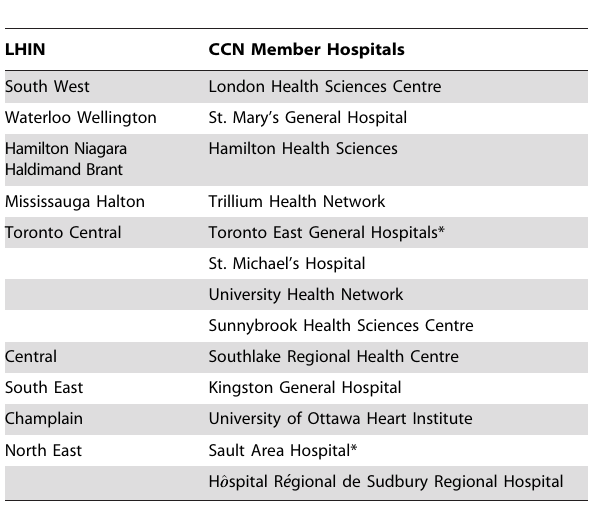
Table 2. The relationship between CCN member hospitals and the